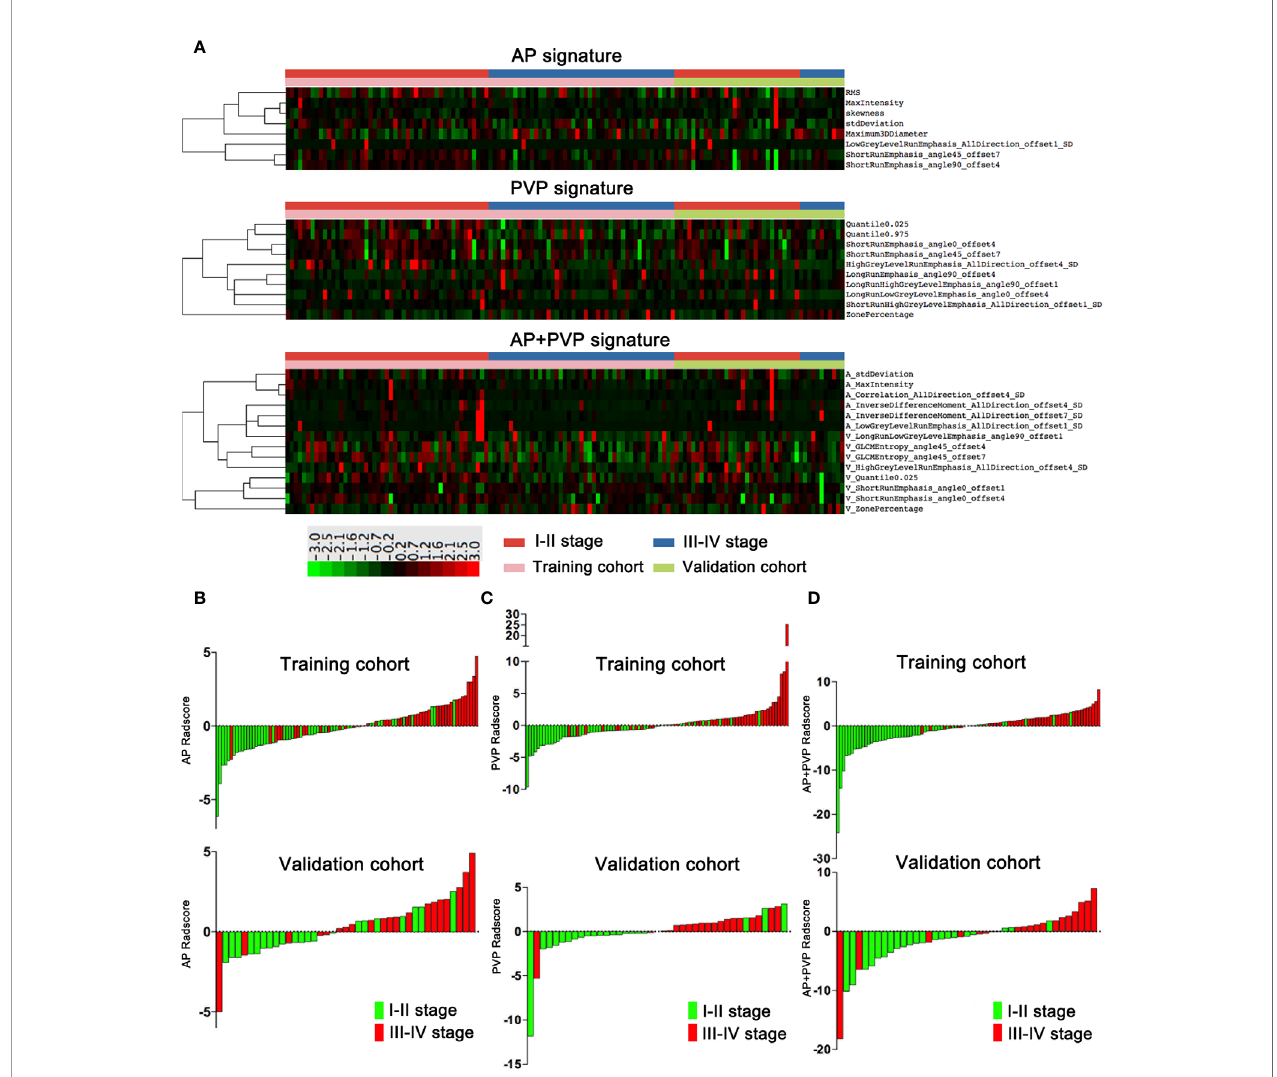
FIGURE 4 | Rad-scores of the AP, PVP, and AP+PVP signatures. (A) Heatmap of 8, 10, and 14 radiomics features in the AP, PVP, and AP+PVP signatures, respectively. Each row corresponds to one radiomics feature, and each column corresponds to one patient. The heatmap is grouped according to the stage I-II versus III-IV stage groups in training and validation cohorts. The leftmost lines represent hierarchical clustering of radiomics features, shown as a dendrogram. (B – D) AP, PVP, and AP+PVP rad-score of each patient in the training and validation cohorts. rad-score, radiomics score; AP, arterial phase; PVP, portal vein